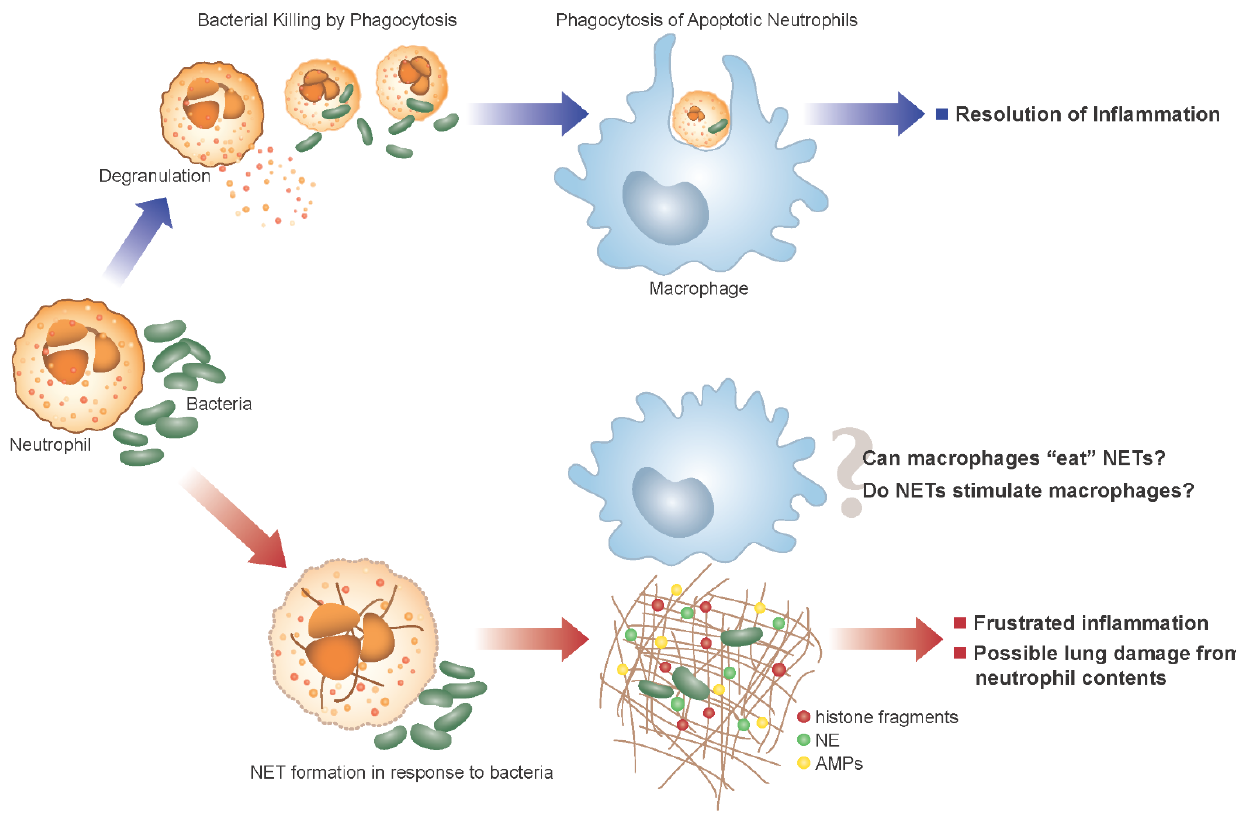
Figure 1. Alternative fates of Neutrophils in the Cystic Fibrosis (CF) lung. In the normal lung (purple arrows/top panel), neutrophils encounter and phagocytose bacteria. Following phagocytosis neutrophils rapidly undergo apoptosis and clearance by macrophages thus (red arrows/bottom panel) may lead to neutrophils forming neutrophil extracellular